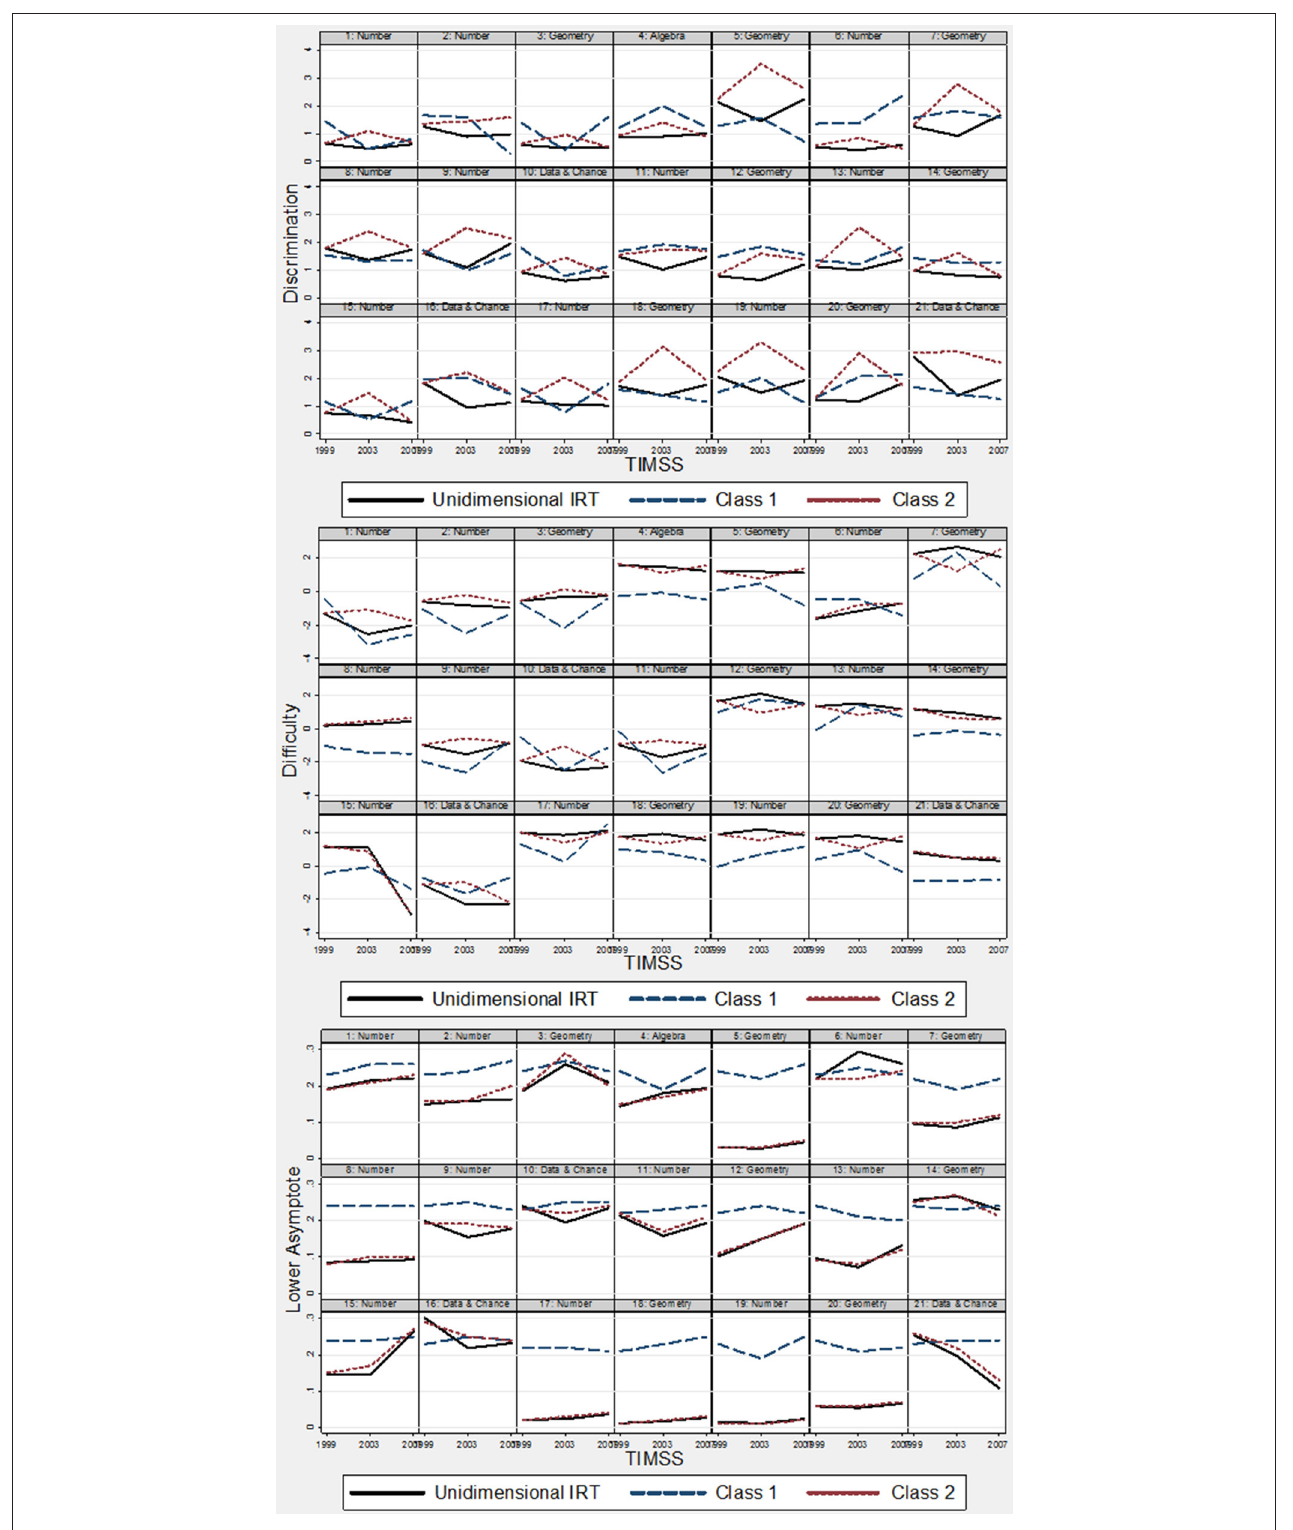
FIGURE 2 | Plots of changes in item parameters by item: TIMSS 1999, 2003, and 2007.